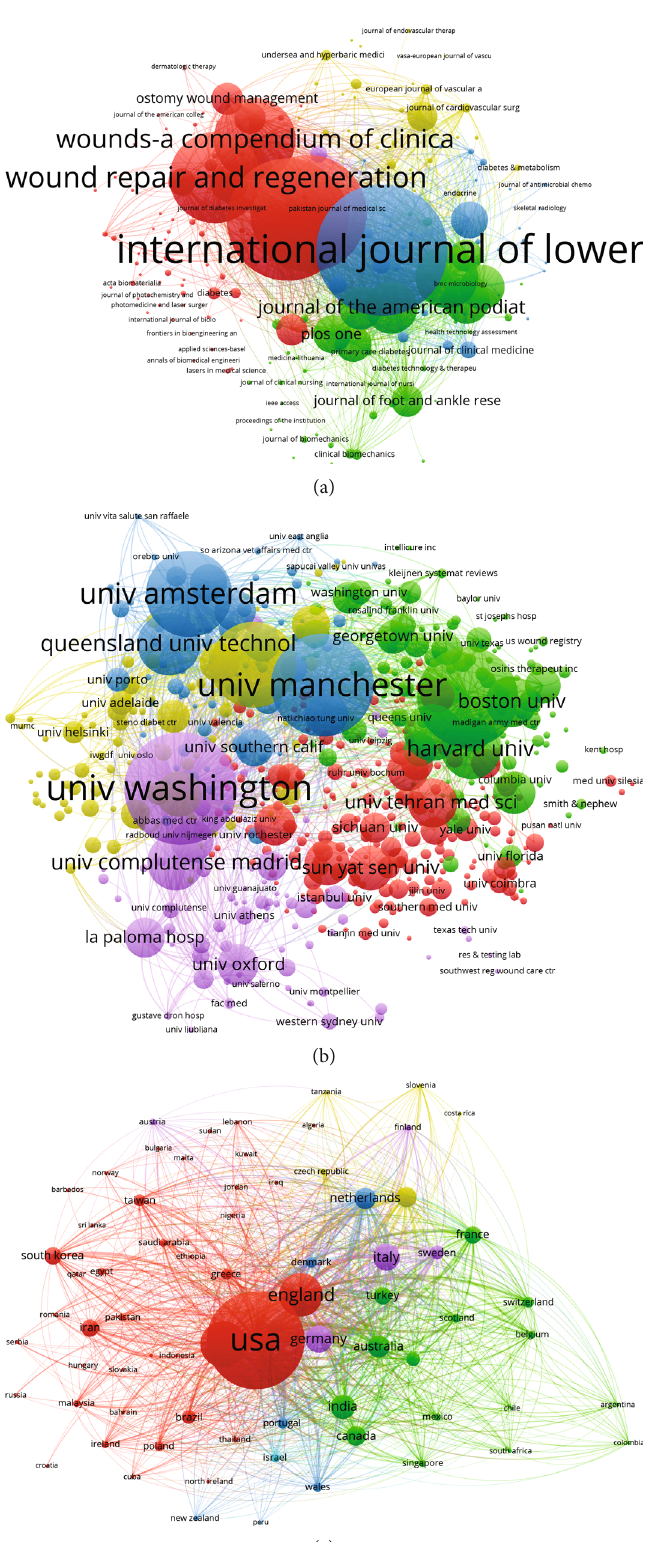
Figure 7: Bibliographic coupling analysis of global research on DFU. (a) Mapping on the 195 included journals in the DFU area. (b) Mapping on the 579 institutions on DFU research. (c) Mapping on the 72 countries in this fi eld. The line between the two nodes indicates the similarity relationship between the corresponding